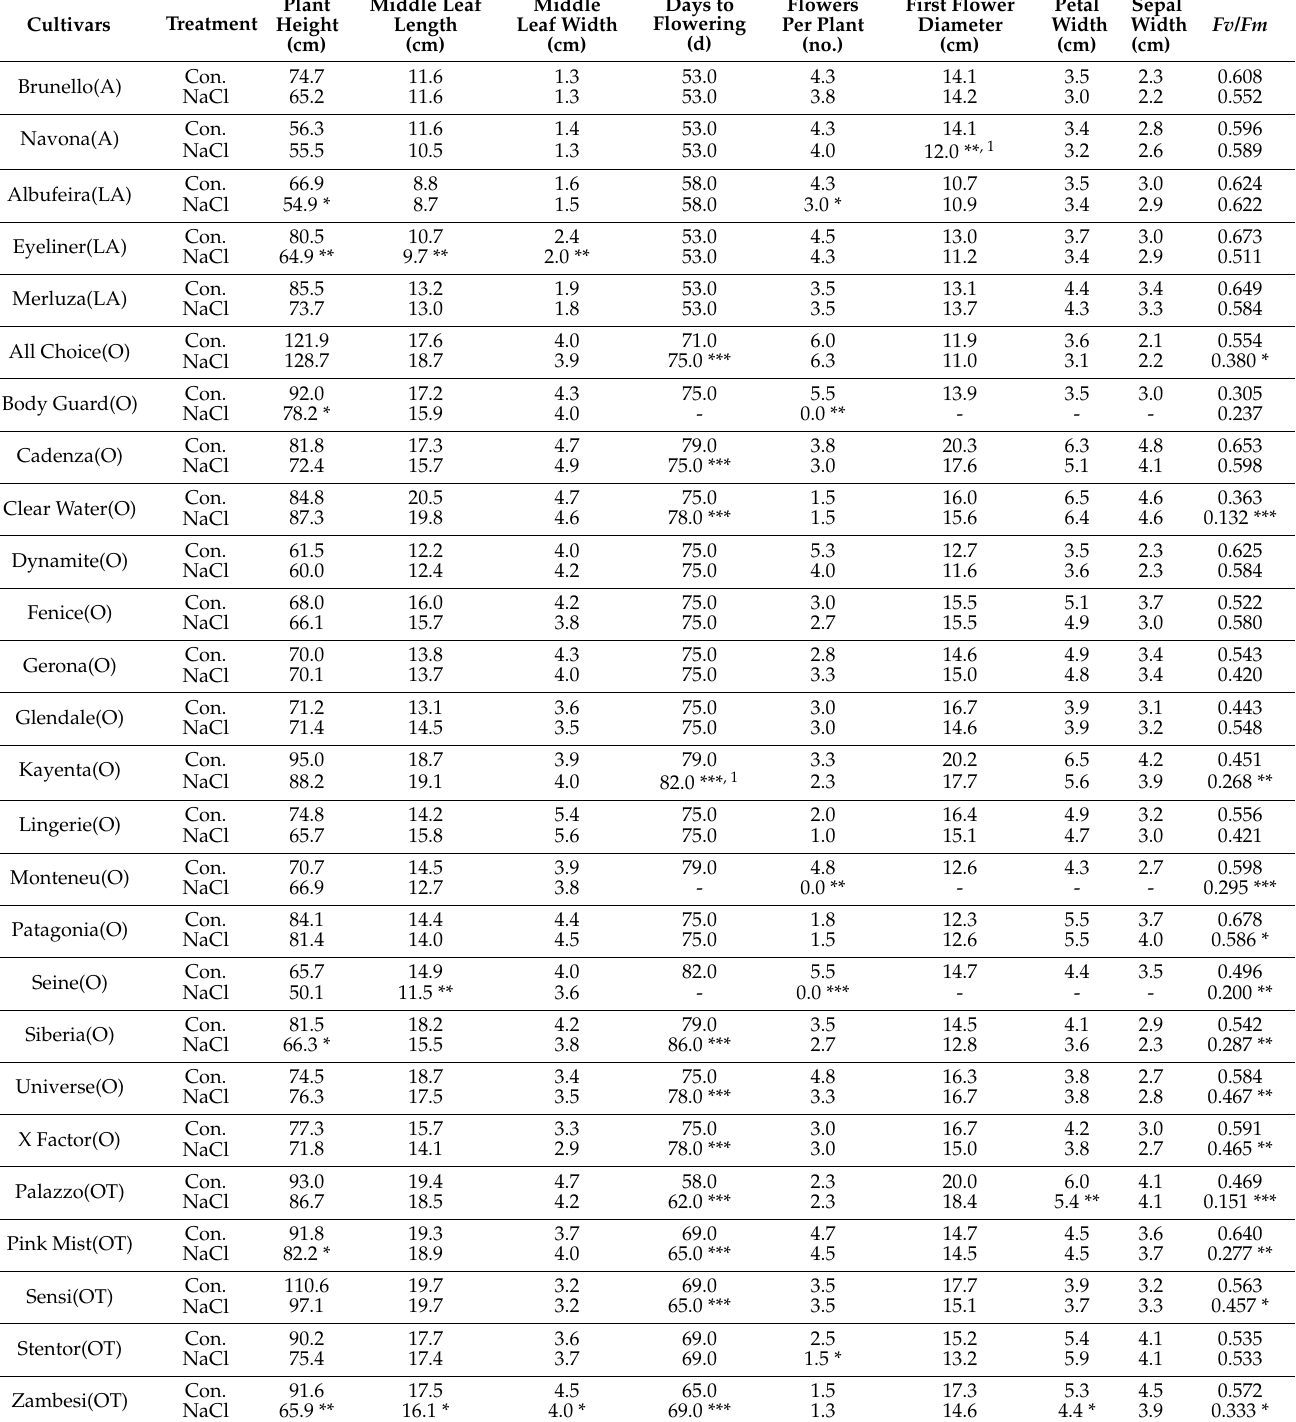
Table 3. The comparison of the flower characteristics and the growth trait means of cut lily cultivars exposed to NaCl treatment (8 dS m − 1 ) and control conditions. Asiatic hybrids (A), LA interspecific hybrids from interspecific crosses between L. longiflorum and Asiatic hybrids (LA), Oriental hybrids (O), and OT interspecific hybrids from interspecific crosses between Oriental hybrids and Trumpet hybrids